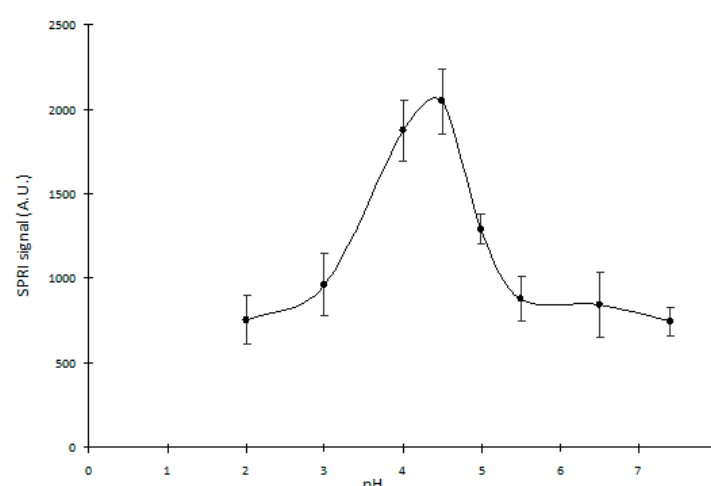
Figure 2. The dependence of the Surface Plasmon Resonance Imaging (SPRI) signal (A.U.) on the pH of the Cathepsin L (CTSL) solution. CTSL standard solution concentration is 10.00 ng/mL. Error bars are the standard deviation of the average SPRI signal of each standard solution determined from twelve independent measurements.